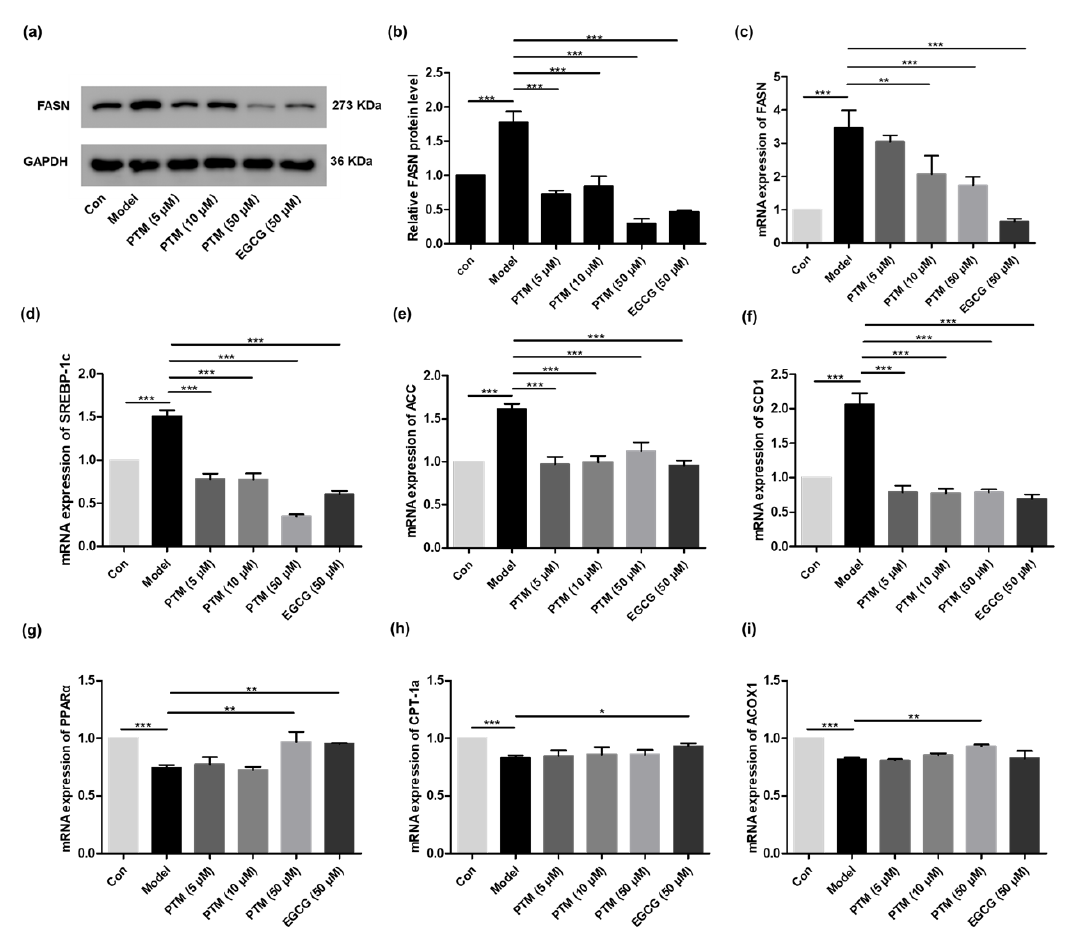
Figure 5. Effects of PTM on mRNA and protein abundance of target proteins involved in lipid metabolism in HepG2 cells. ( a ) Western blot analysis of the effects of PTM on the level of FASN, using EGCG as a control. ( b ) Protein blot densities were quantified by ImageJ Software; protein expression was normalized to GAPDH. ( c ) – (i f ). Quantitative RT-PCR anal- yses of the mRNA levels of FASN, SREBP-1c, ACC, SCD1, CPT- 1a, PPARα, and ACOX1, relative to the internal control β - actin. Data were visualized by GraphPad software. Error bars represent means ± SD. * p < 0.05, ** p < 0.01, *** p < 0.001.